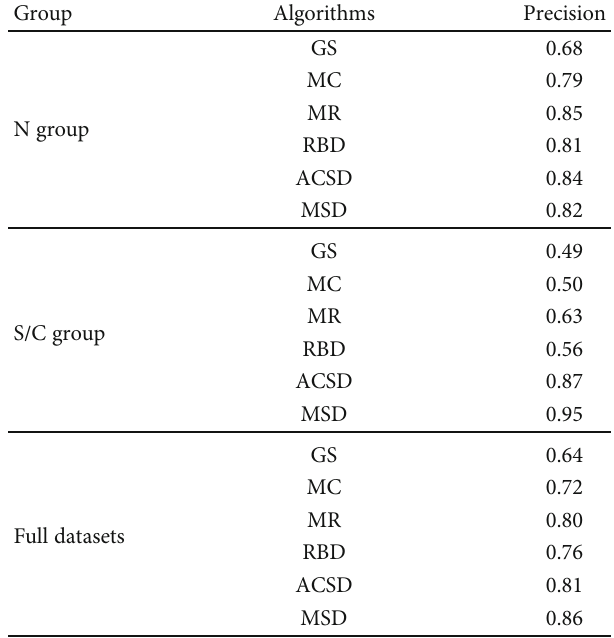
Table 1: The performance of di ff erent algorithms tested on three